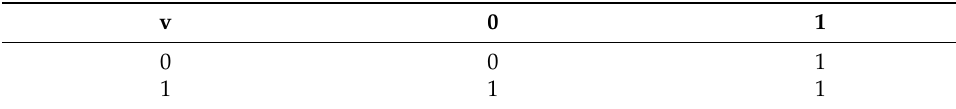
Table 1. Operator